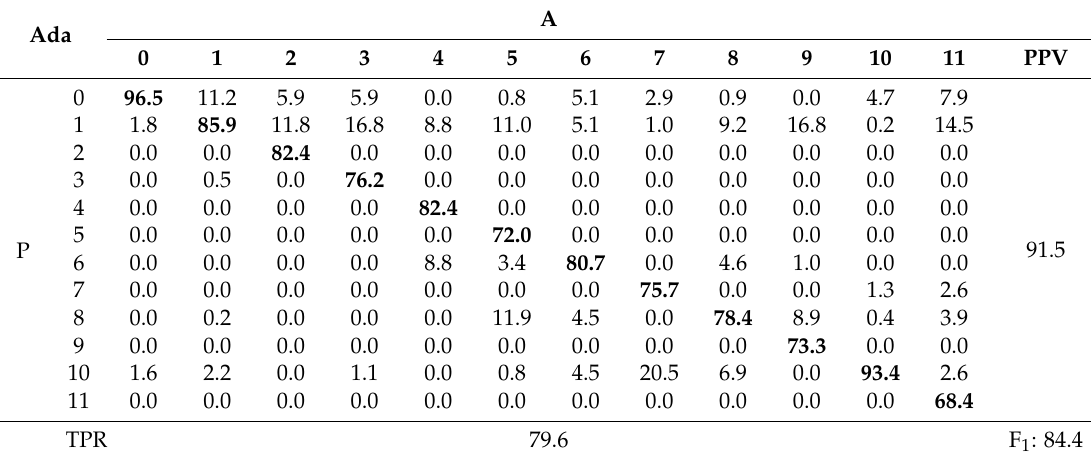
Table 10. The Confusion Matrix of the AdaBoost